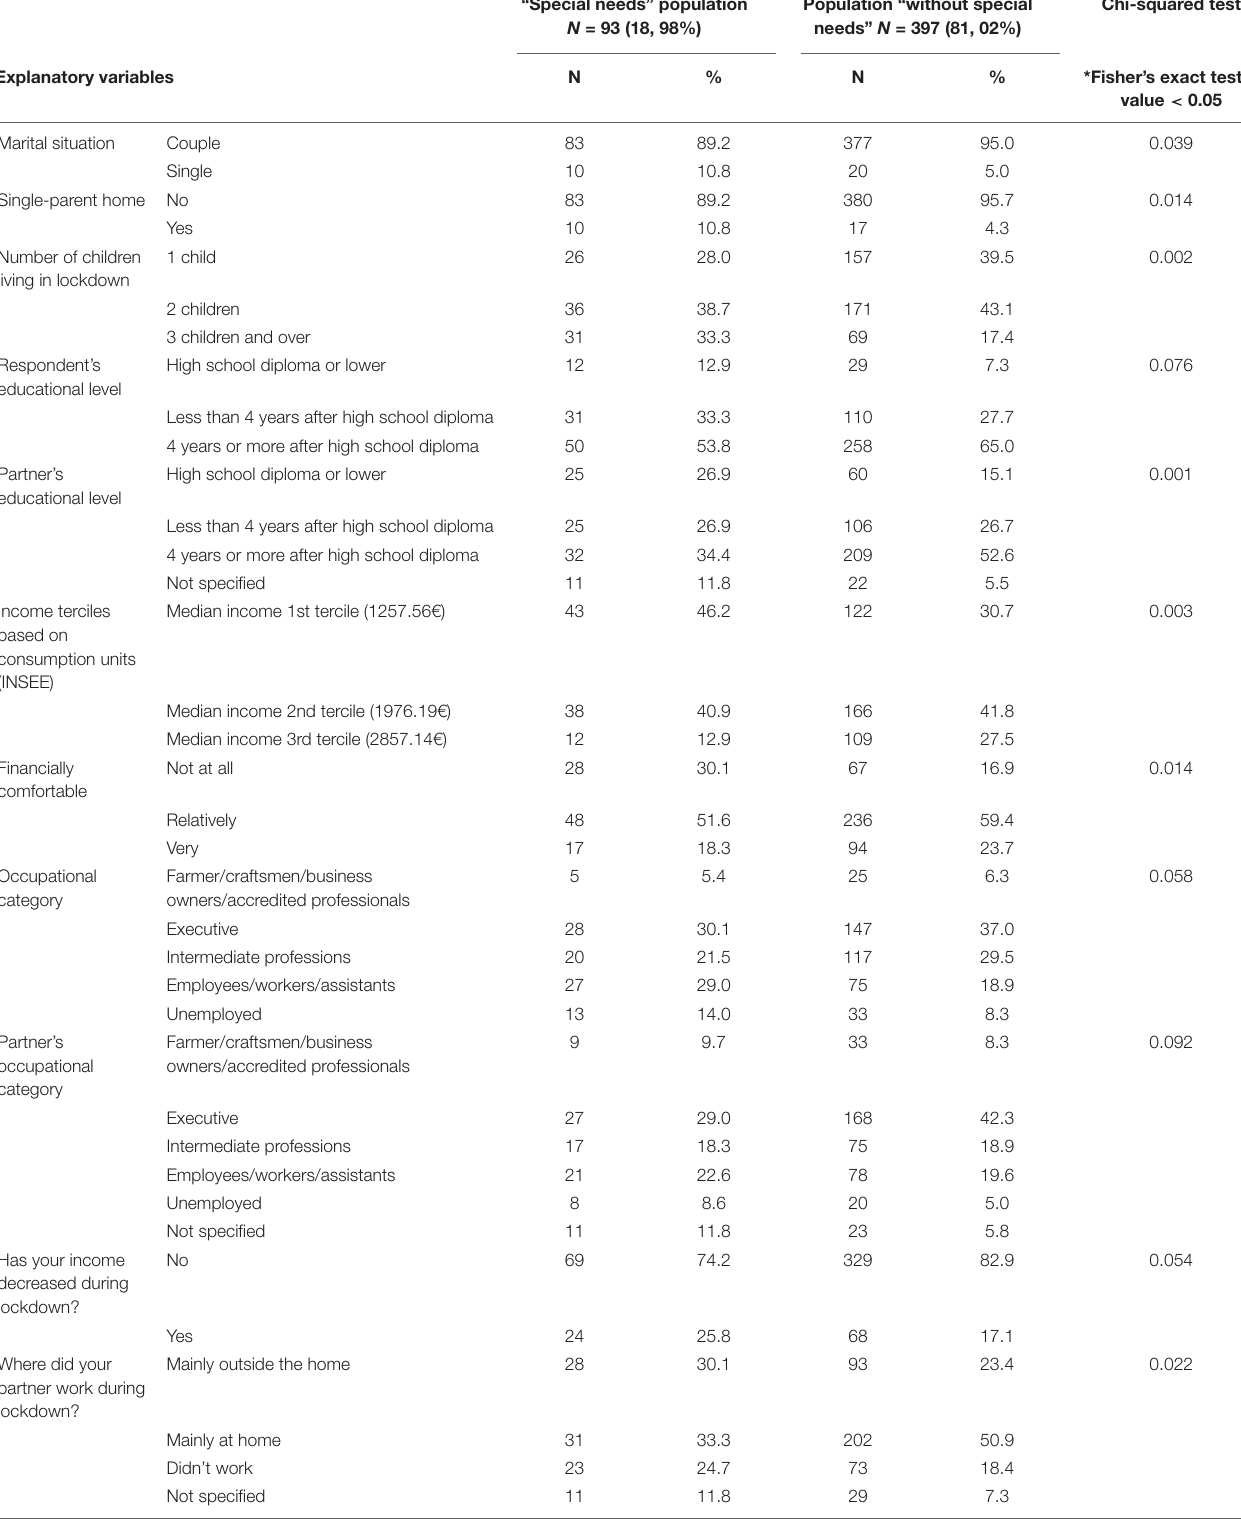
TABLE 2 | Sociodemographic characteristics: bivariate analyses of “special needs” population vs. “population without special needs.”